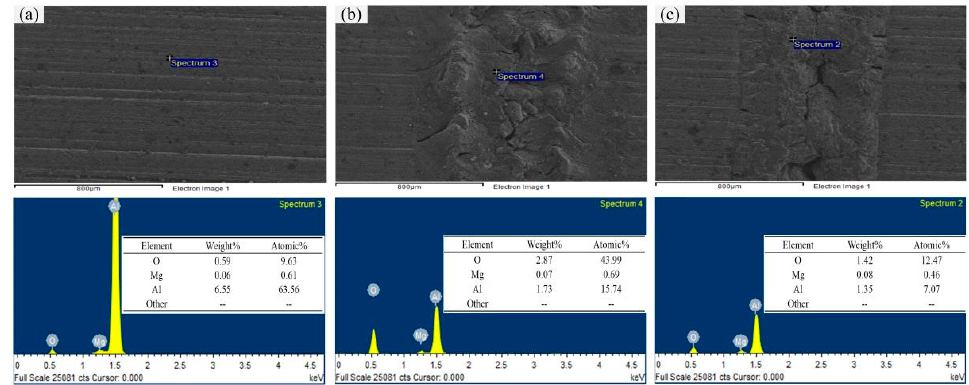
Figure 9. EDS analysis of aluminum alloy before and after processing. ( a – c ) show the elemental analyses of aluminum alloy unprocessed, laser-processed in air and laser-processed in